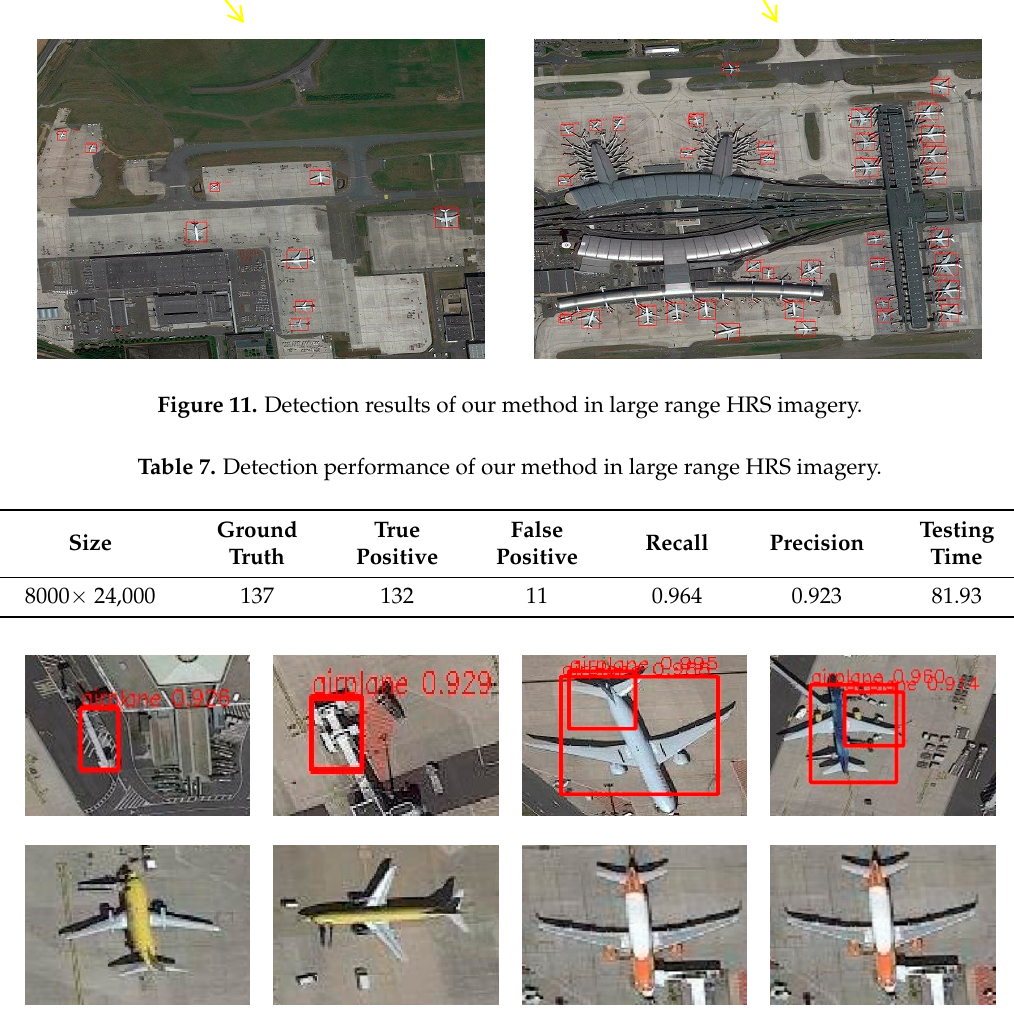
Figure 12. Some typical false alarms and missing targets among the detection results of our method: the first row are some typical false alarms, while the second row are some missing